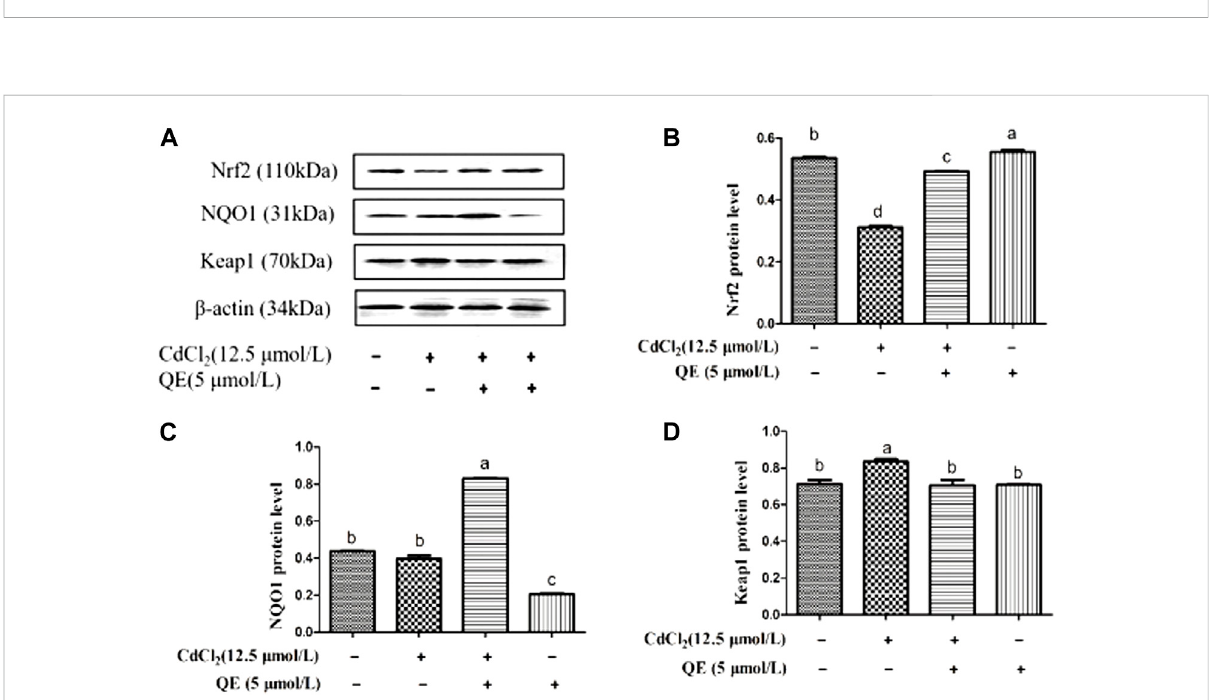
FIGURE 5 Effects of QE on protein expression of Cd-induced the Nrf2 signal pathway related genes in BRL-3A cells. The levels of Nrf2, NQO1 and Keap1 proteins (A) weremeasuredbyWesternblot.TheproteinlevelsofNrf2 (B) NQO1 (C) andKeap1 (D) inBRL-3Acells. β -actinwasusedasacontrol.The data are expressed in the form of mean ± SEM, and data with different letters (a, b, and c) represent signi fi cantly different ( p < 0.05) among different